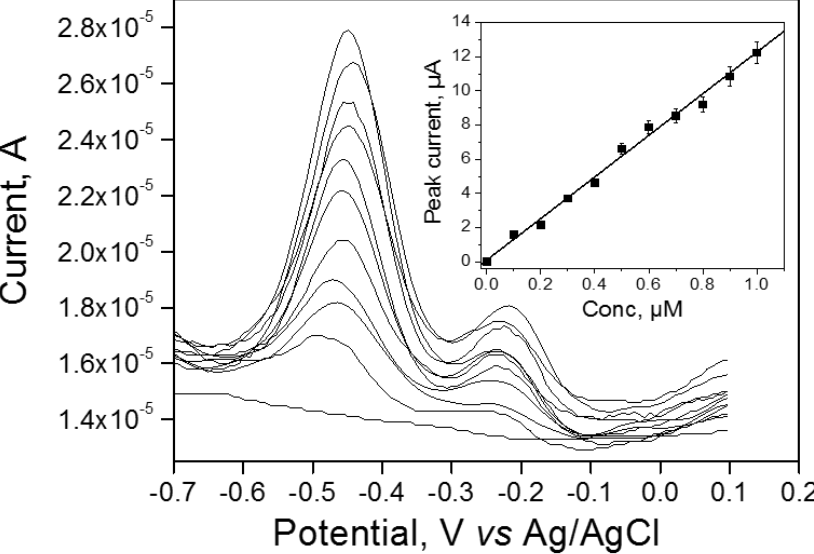
Figure 6. Differential pulse voltammetry (DPV) curves obtained on GCE/Lys/HA in PBS (pH 8) at various concentrations (0, 0.1, 0.2, 0.3, 0.4, 0.5, 0.6, 0.7, 0.8, 0.9, and 1 µM (DPV curves are ordered from bottom to top, respectively)) of NBA. The first peak, which is the most intense, was used to plot the concentration dependency. (The inset shows the corresponding calibration curve). Table 3. Comparison of the performances of the developed sensor GCE/Lys/HA with respect to the electroanalysis of Nile blue A, with those of other modified electrodes applied to the electroanalysis of similar